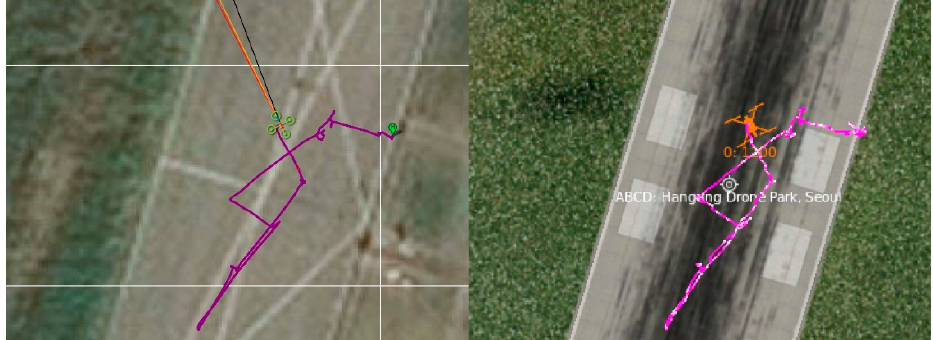
Figure 19. Flight Task 3, flight trajectory of the real ( left ) and the virtual quadcopters ( right ).